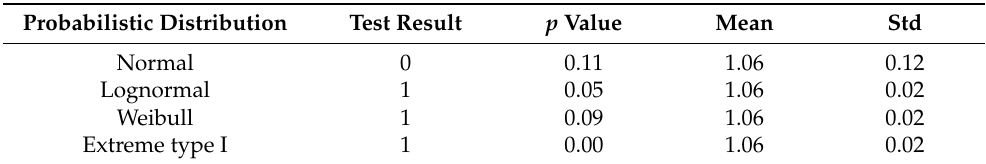
Figure 7. K-S testing of the distribution of model uncertainty. ( a ) PDF, ( b ) CDF. Table 1. Statistical table of the uncertainty factor K P. Table 2. The K-S test result of the model uncertainty.